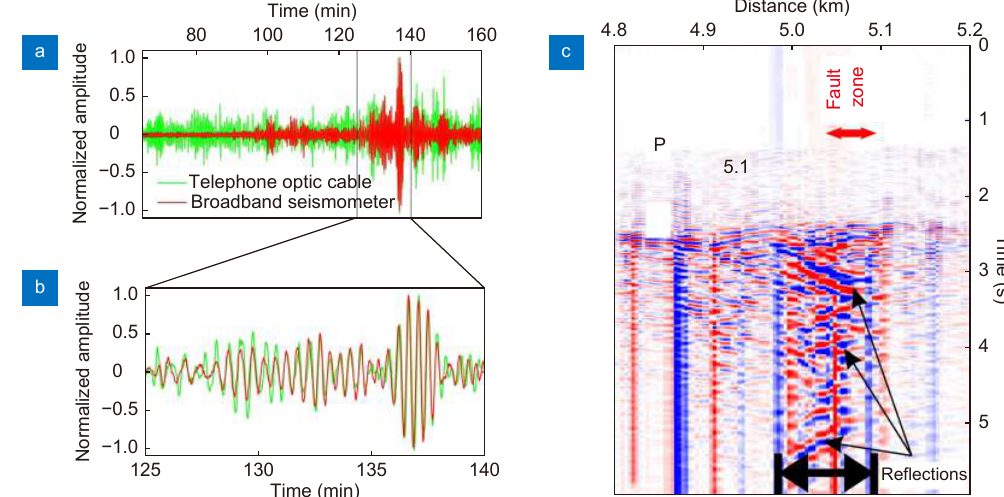
Fig. 4 | ( a ) Normalized strain (green curve) recorded during an Mb ~6.2 (USGS) earthquake (Kota Ternate, Indonesia, 2015-03-17 22:12:28 UTC, 1.669°N; 126.522°E, 44 km depth) superimposed with the normalized velocity record (red curve) from the broadband station RAH (80 m from the optical cable). ( b ) Zoom-view from (a) showing a good phase correspondence between seismometer velocity record and DAS strain re- cords at a 20s period. ( c ) Short record (6 s) of strain phases from a local earthquake trapped in the fault damage zone. Waves inside and out- side the fault zone have different apparent velocities. Figures reproduced from ref. 98 , under a Creative Commons Attribution 4.0 International